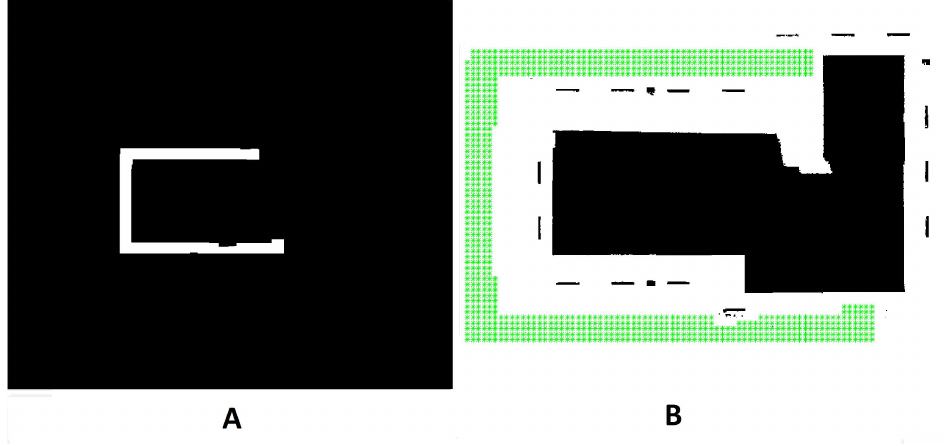
Figure 6. The buffer of the optimum camera range on the map ( A ); the sample points on the buffer of optimum camera range ( B ).